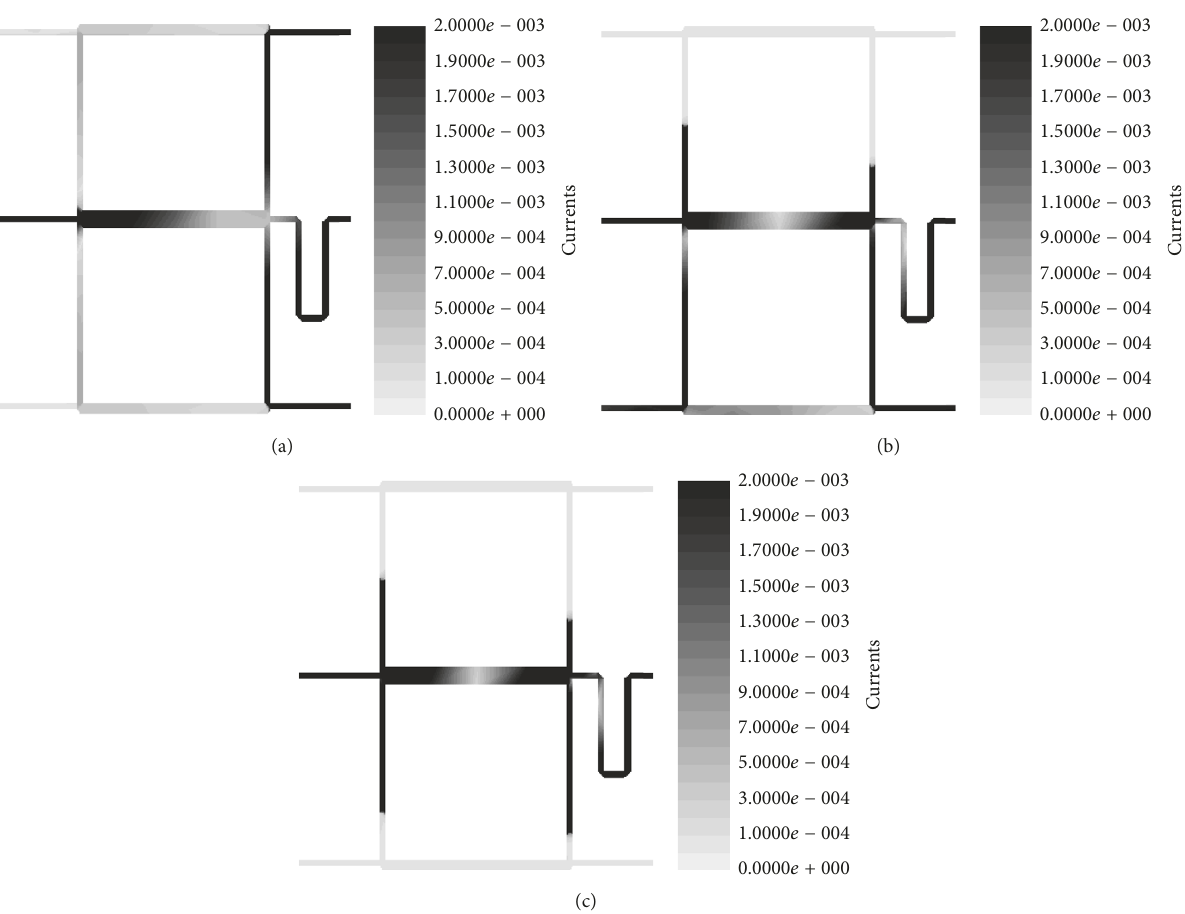
Figure 2: Simulated current distributions with (a) 0, (b) 2, and (c) 4 shorting pins.